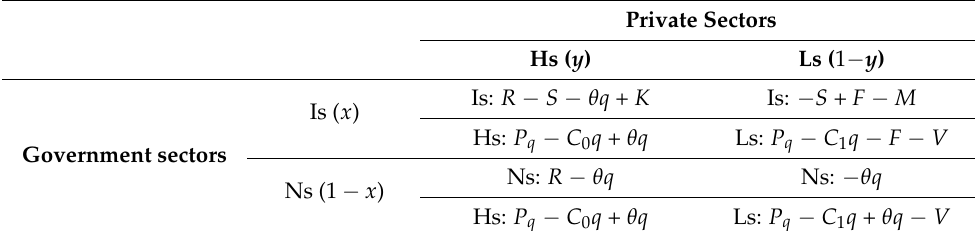
Table 2. Payoff matrix of government sectors and private